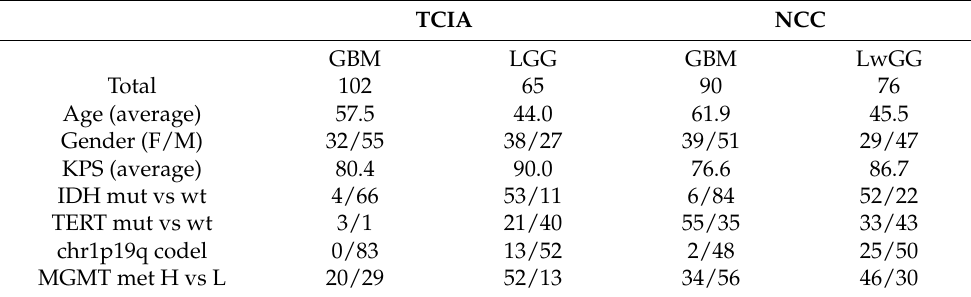
Table 1. Demography of glioma patients in two different datasets used in this study, The Cancer Image Archive (TCIA) and National Cancer Center Hospital Japan (NCC). Each row represents the statistics or number of people assigned to each category for GBM and lower grade glioma patients. For genomic alterations, the number of people carrying IDH mutations, TERT promoter mutations, chr 1p19q codeletions, and higher levels of MGMT promoter methylation was separated from those of others via slash. TCIA NCC GBM LGG GBM LwGG Total 102 65 90 76 Age (average) 57.5 44.0 61.9 45.5 Gender (F/M) 32/55 38/27 39/51 29/47 KPS (average) 80.4 90.0 76.6 86.7 IDH mut vs wt 4/66 53/11 6/84 52/22 TERT mut vs wt 3/1 21/40 55/35 33/43 chr1p19q codel 0/83 13/52 2/48 25/50 MGMT met H vs L 20/29 52/13 34/56